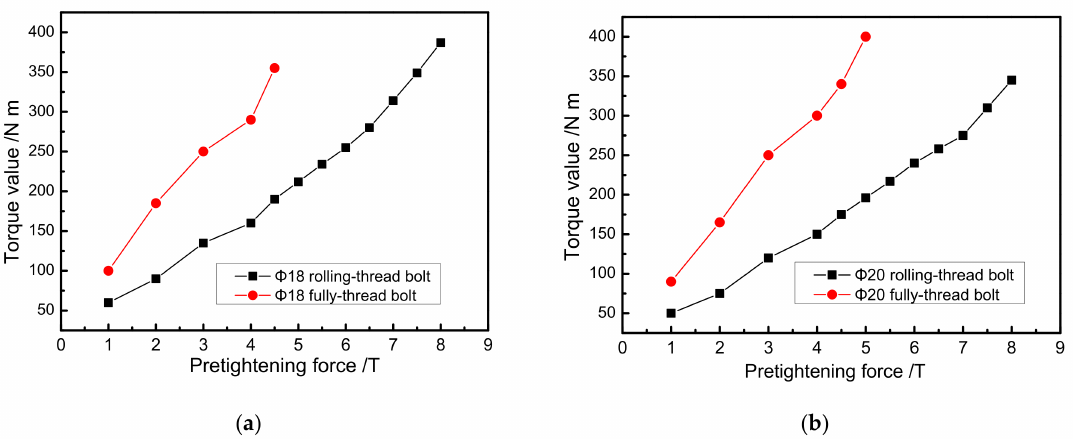
Figure 6. Test curve of torque-pretightening force. ( a ) Φ 18 bolt; ( b ) Φ 20